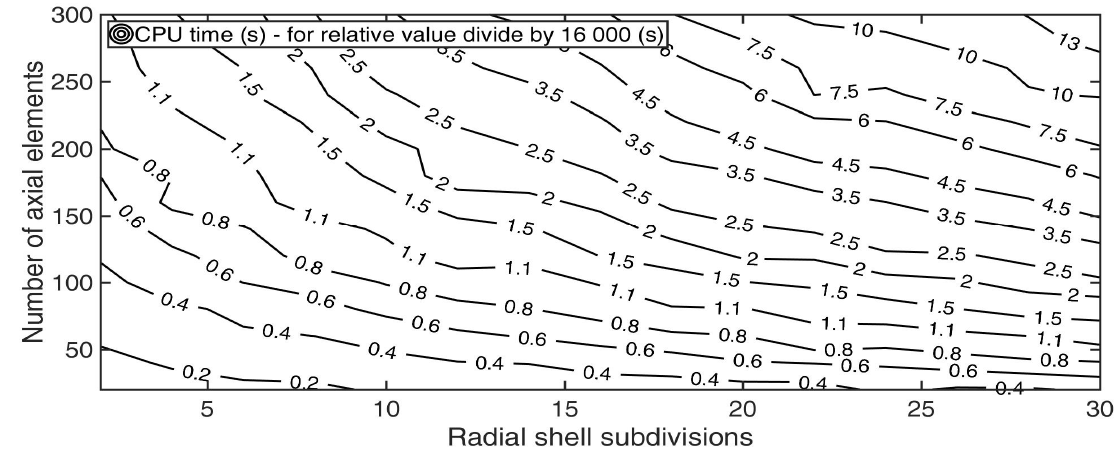
arrow signifies the ideal direction for discretization.